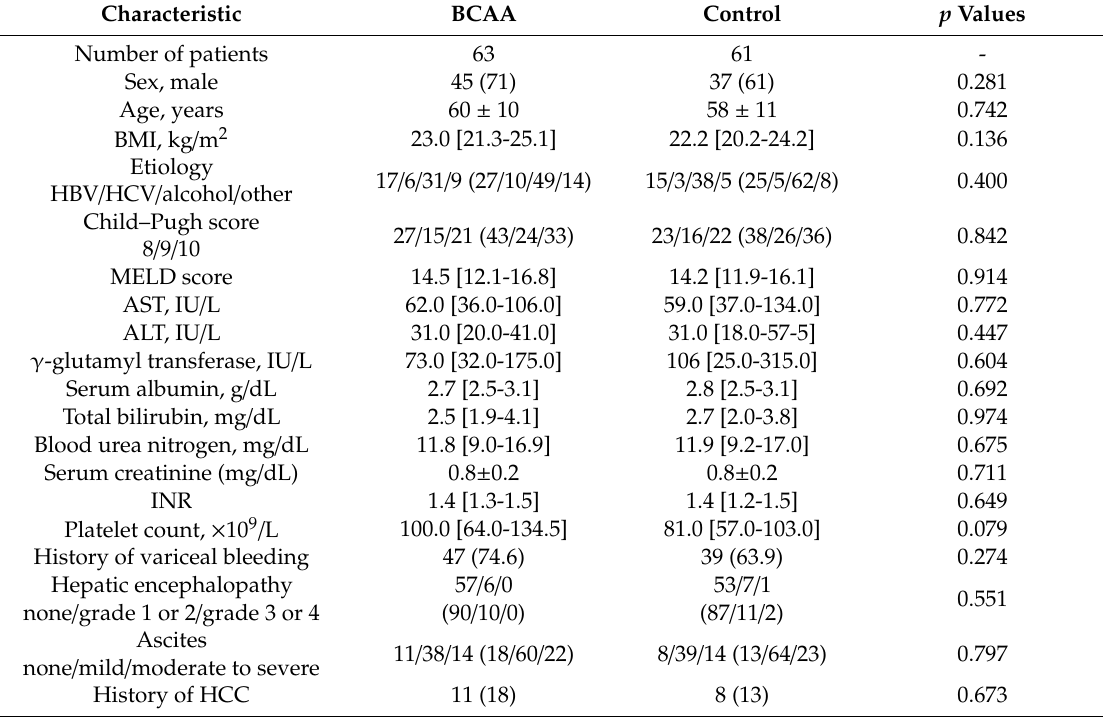
Table 1. Baseline characteristics in the branched-chain amino acid (BCAA) and control